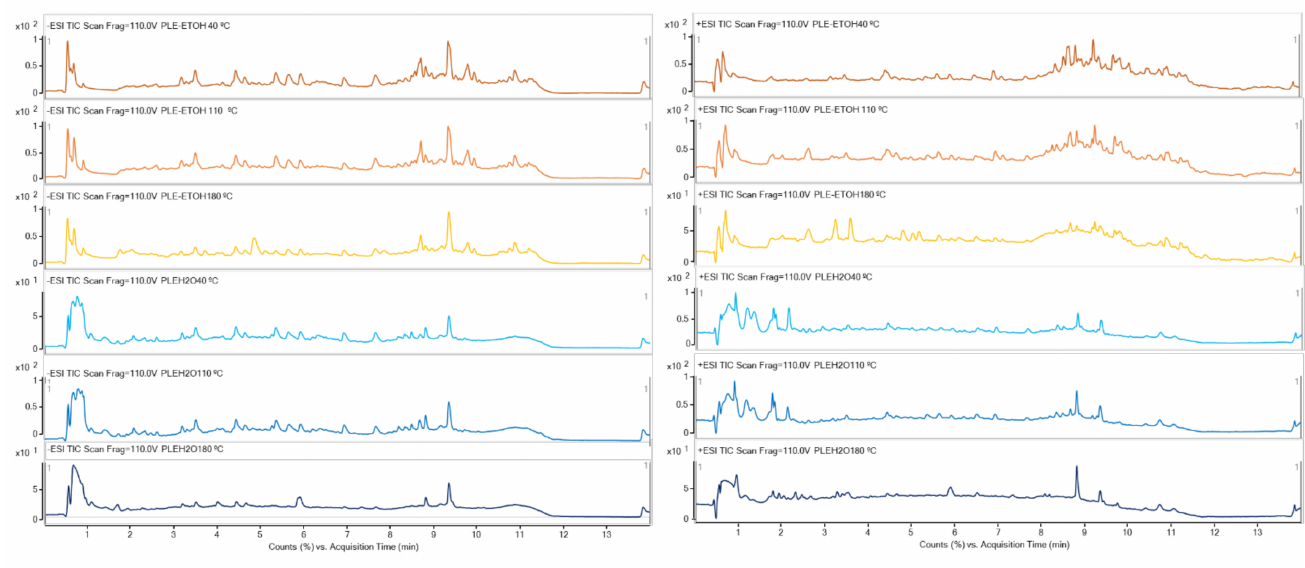
Figure 3. UHPL-ESI-qTOF Chromatograms (Total Ionic Current, TIC) of the pressurized liquid extracts of Ammodaucus leucotrichus fruits obtained using 10 min of extraction time at indicated temperatures. Left side negative polarity, right side positive polarity. Orange chromatograms correspond to ethanolic extracts, blue chromatograms correspond to water extracts. Extraction temperature is indicated above each